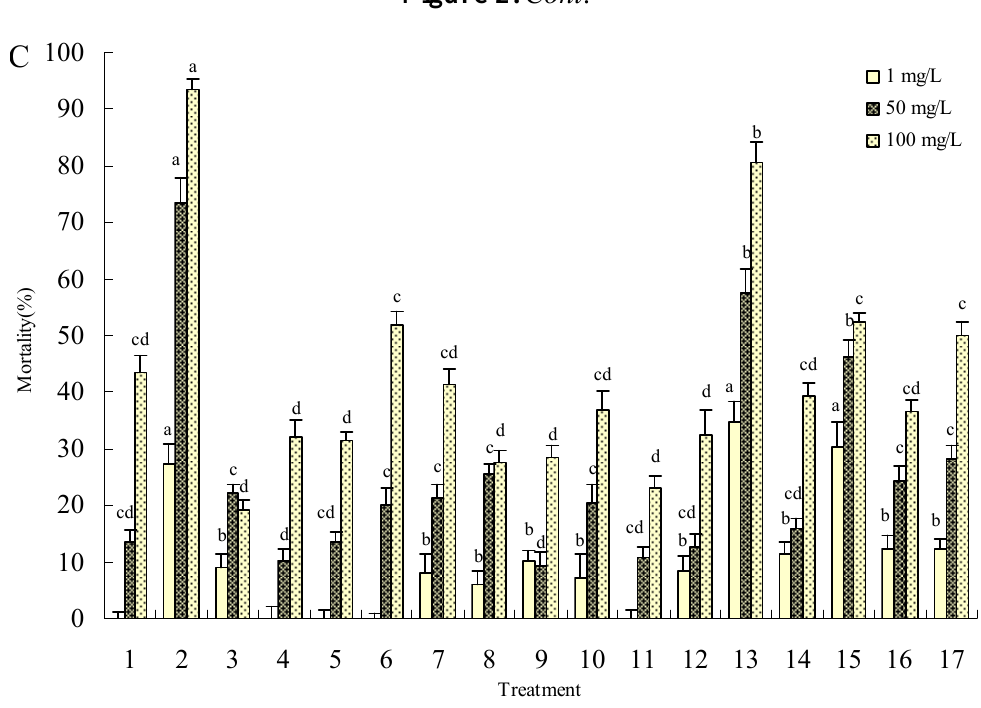
Figure 3. Toxic effect of compounds 1-16 on mustard aphids ( L. erysimi ). A is the effect